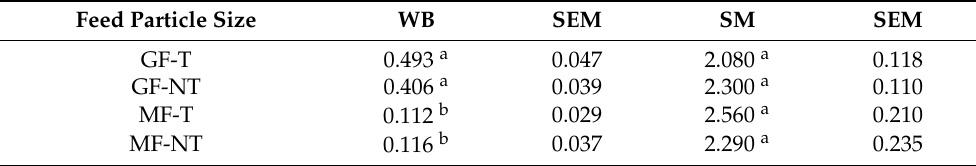
Table 4. Incidence of WB and SM (expressed as a percentage) depending on the feed form presentation and the use or not of veterinary treatments. Feed Particle